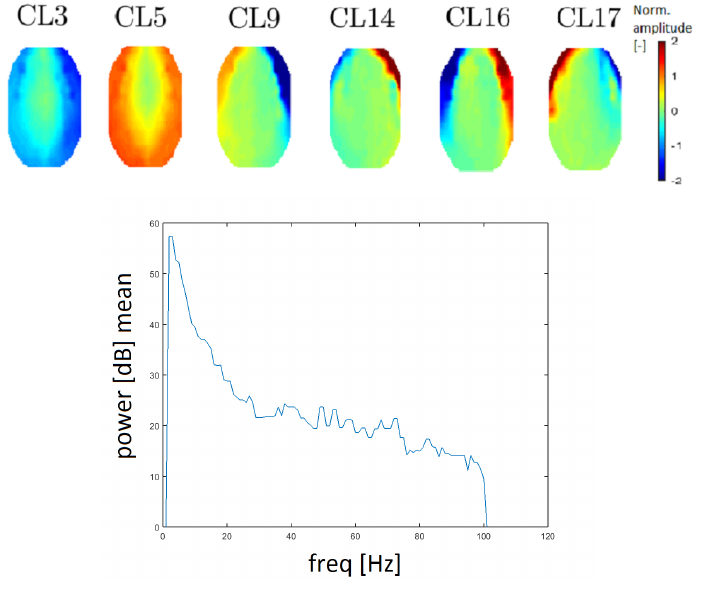
Figure 10. Topomaps of clusters that represent electromyographic (EMG) artifacts ( top ). The mean power spectrum after median filtration of the CL9 cluster, which represents EMG artifacts ( bottom